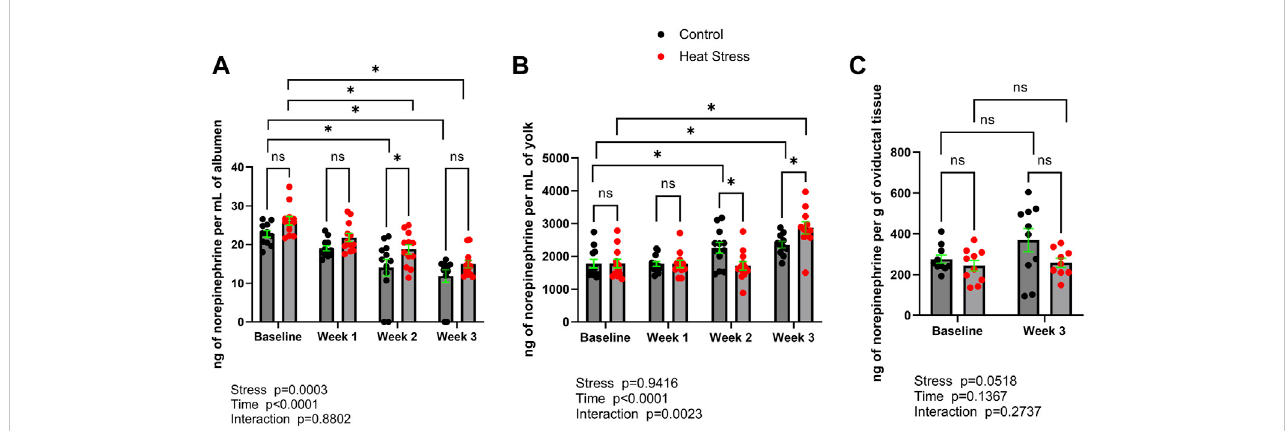
FIGURE 1 Norepinephrineconcentrations inalbumen (A) , yolk (B) , oroviductaltissue (C) incontrol or heat stress groups atbaseline or after 1, 2, or3 weeksofheat stress. Signi fi cantdifferences ( p < 0.05)wereindicated with *.Values arengper mLof albumenoryolk,orng perg ofoviductal tissue.All values are expressed as mean ± SEM ( n = 12 eggs/timepoint/group or for oviductal tissue n = 9 – 10